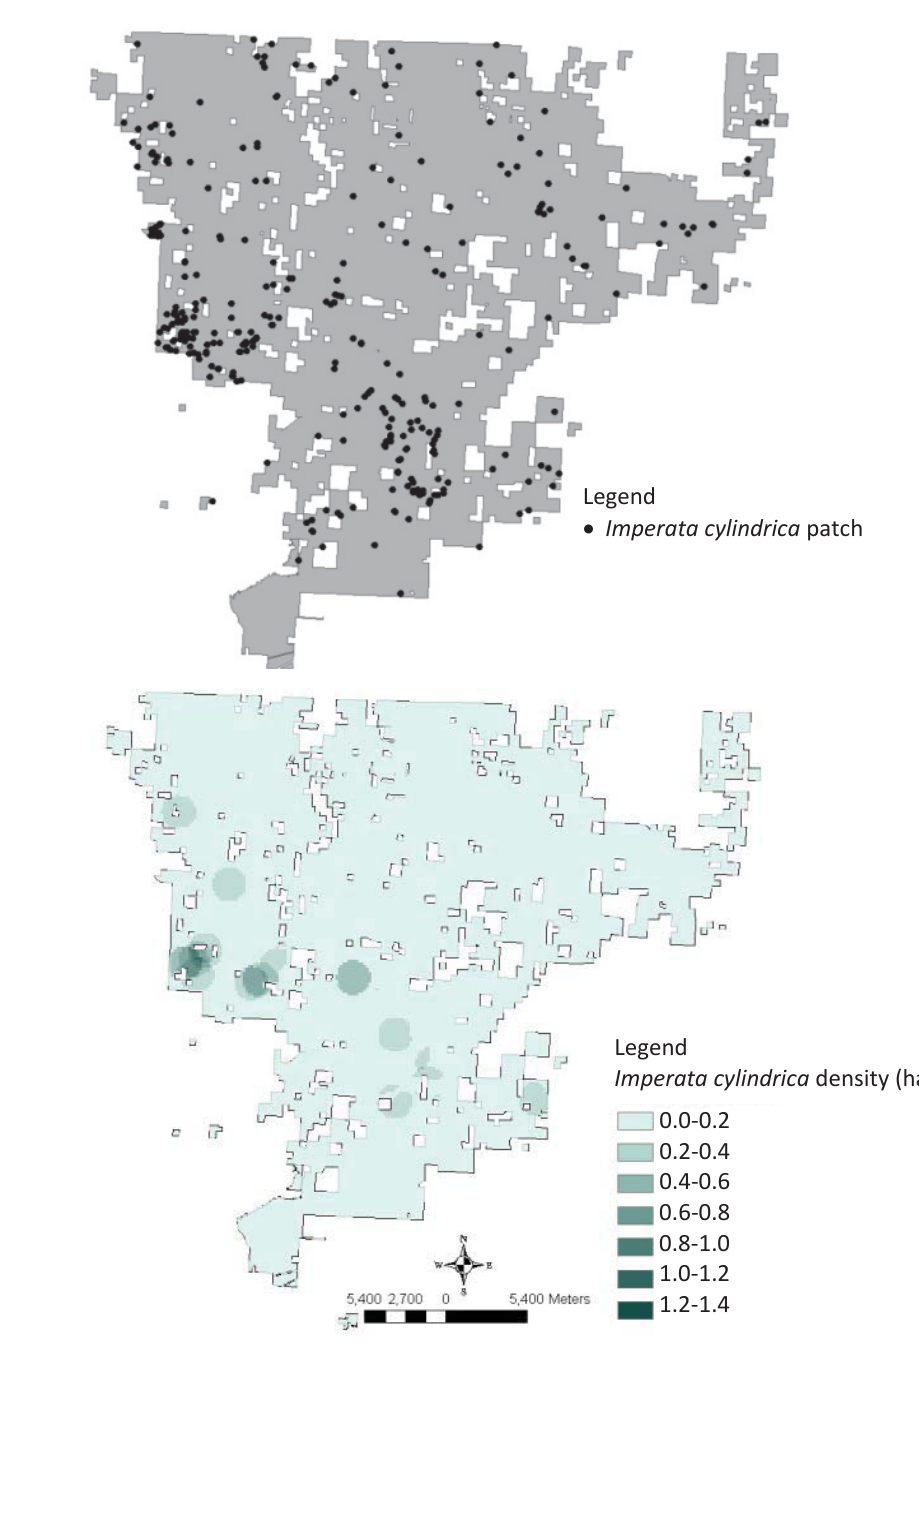
Figure 4. Map of Blackwater River State Forest showing the location ( A ) and size ( B ) of known Imperata cylindrica